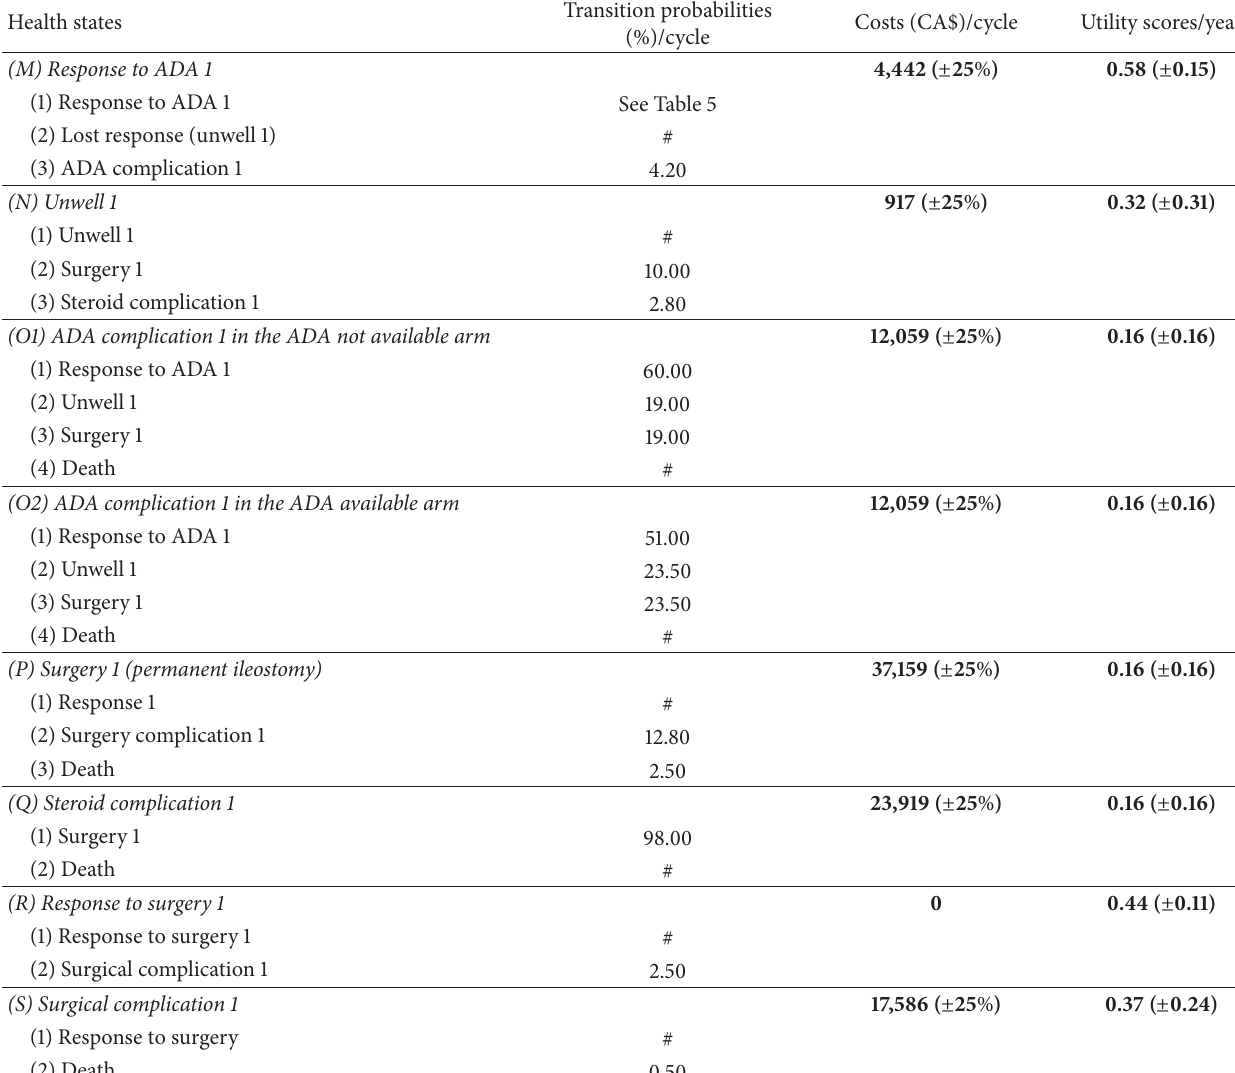
Table 4: Markov model input parameters for chronic